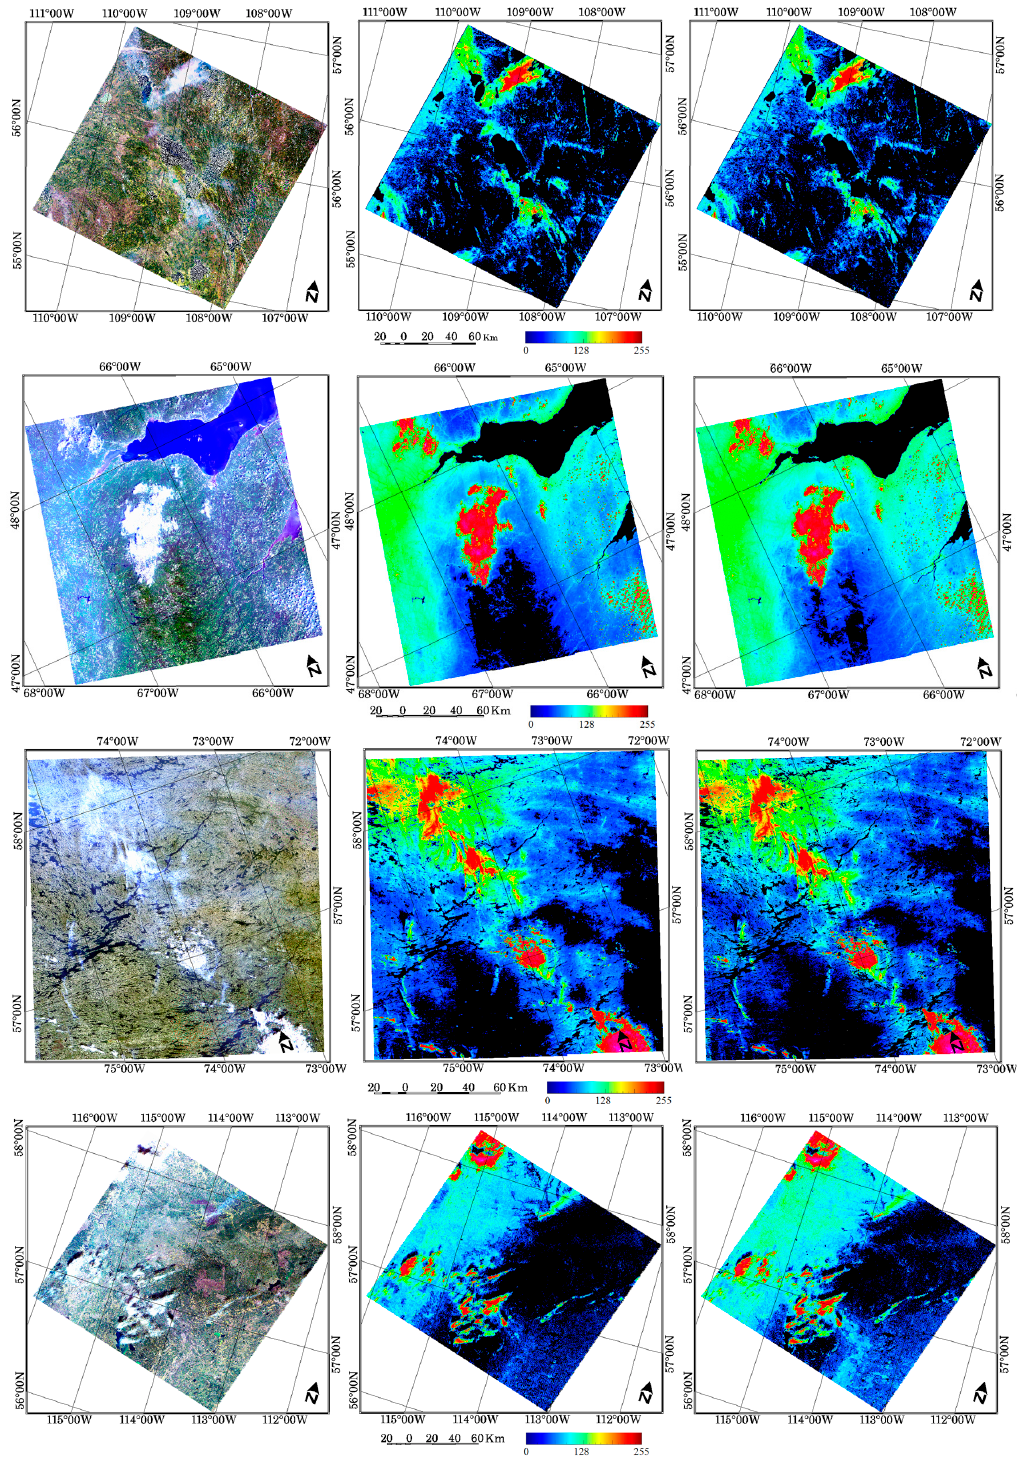
Figure 6. True color images (the first column) and their corresponding HOT images (the second and third columns, color has been adjusted for visualization) created with AutoHOT and Manual HOT for four Landsat scenes with lower overall accuracies in terms of HOT image spatial agreement. The four scenes from top to bottom are: LS5-Path 40/Row 21 (ID: LT50400211984271PAC00); LS8-Path 10/Row 27 (ID: LC80100272014223LGN00); LS8-Path 18/Row 20 (ID: LC80180202013212LGN00); and LS7-Path 44/ Row20 (ID: LE70440202012272EDC00).